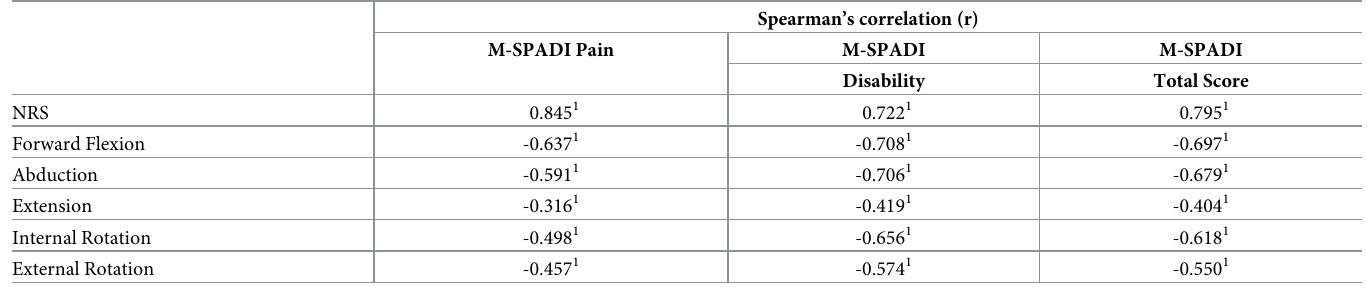
Table 4. Spearman’s correlation coefficient between M-SPADI, NRS, and shoulder active range of motion.